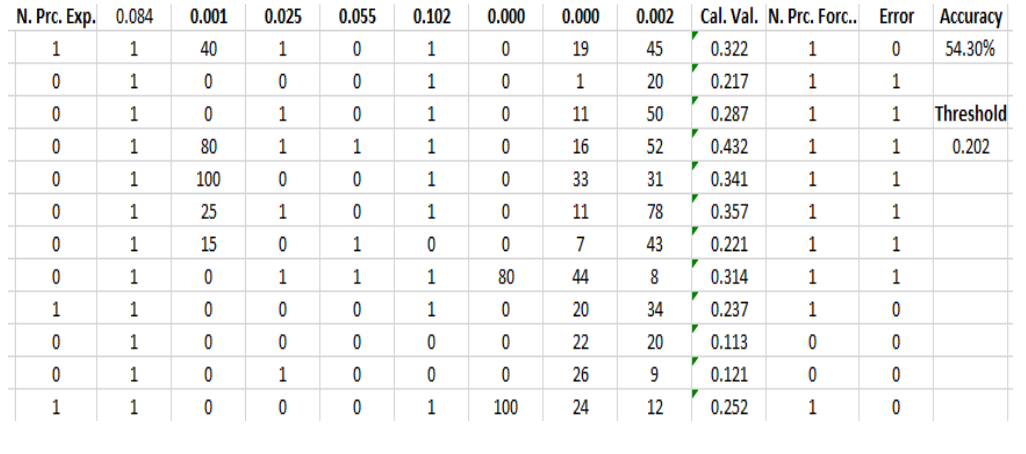
Table 5. Forecasting the impact of access to credit on process